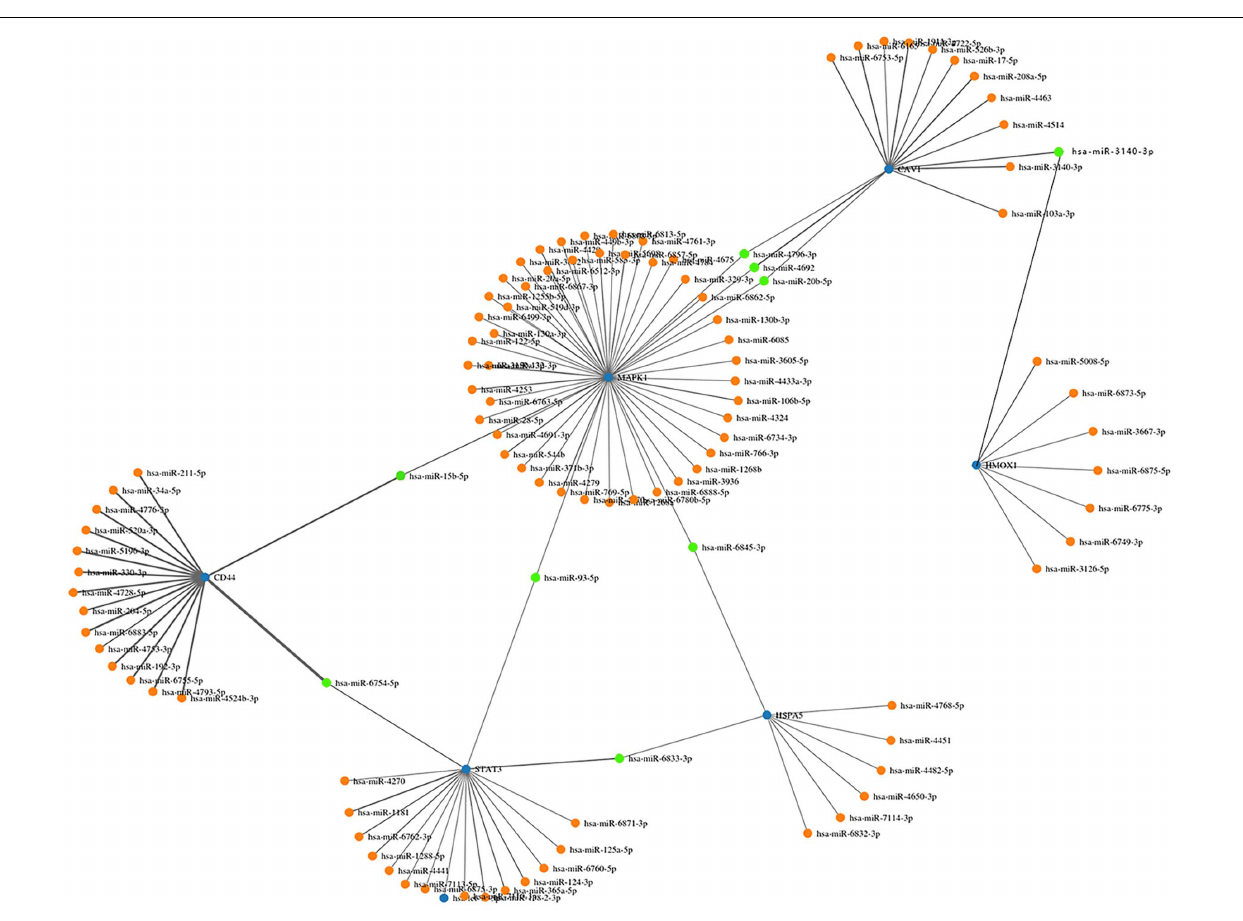
FIGURE 7 | Interaction network between genes of cluster 1 and its targeted miRNAs. Genes were colored in blue, miRNAs were colored in orange, and the cross-linked genes were colored in